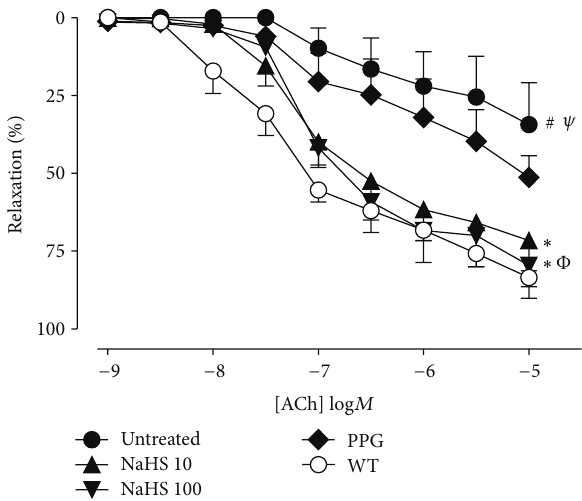
Figure 3: Concentration-response curves to the endothelium- dependent vasodilator acetylcholine (ACh) in aorta from WT ( I ) and fat-fed ApoE −/− mice. ApoE −/− mice are untreated ( ∙ ) or chronicallytreatedwith10( 󳵳 )or100( 󳶃 ) 𝜇 mol/kg/dayNaHSorPPG 30 mg/kg/day ( ⧫ ). Untreated fat-fed ApoE −/− mice had significantly attenuated response to ACh ( 𝑅 max and EC 50 ) ( # ,Ψ 𝑃 < 0.05 , 𝑡 -test, WT versus fat-fed ApoE −/− ). Fat-fed ApoE −/− treated with NaHS at either dose had improved relaxation responses ( 𝑅 max and EC 50 ) to ACh ( ∗,Φ 𝑃 < 0.05 , ANOVA untreated, versus treated), 𝑛 = 5 – 7 .